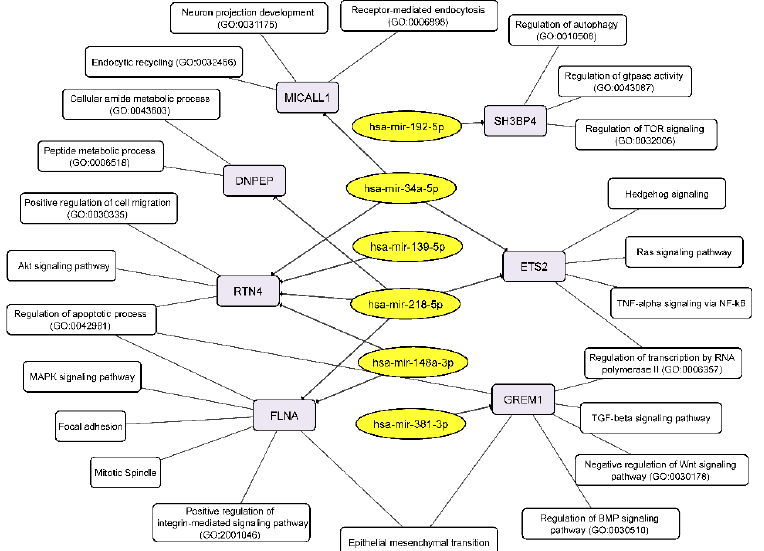
Figure 7. Integrated network analysis of the GBM NS upregulated miRNAs and their targeted downregulated mRNAs, as well as the participation of the latter in cellular processes. Yellow ovals represent miRNAs, gray round rectangles—mRNA-targets, white round rectangles—cellular processes and signaling pathways.